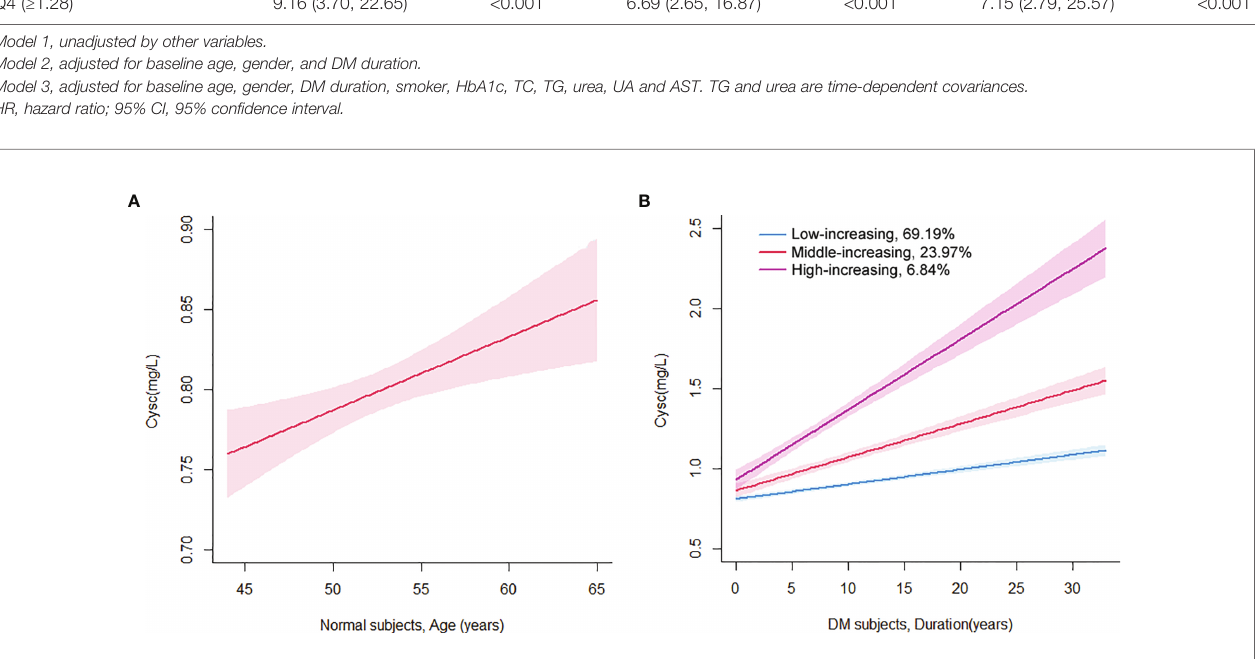
FIGURE 1 | Class-speci fi c mean predicted trajectory of serum cystatin C for healthy subjects (A) and T2DM patients (B) . A one-class linear model was selected for healthy subjects by age (A) , and a three-class linear model was selected for T2DM patients by DM duration as the best- fi t models, adjusted for the covariate of age (B)